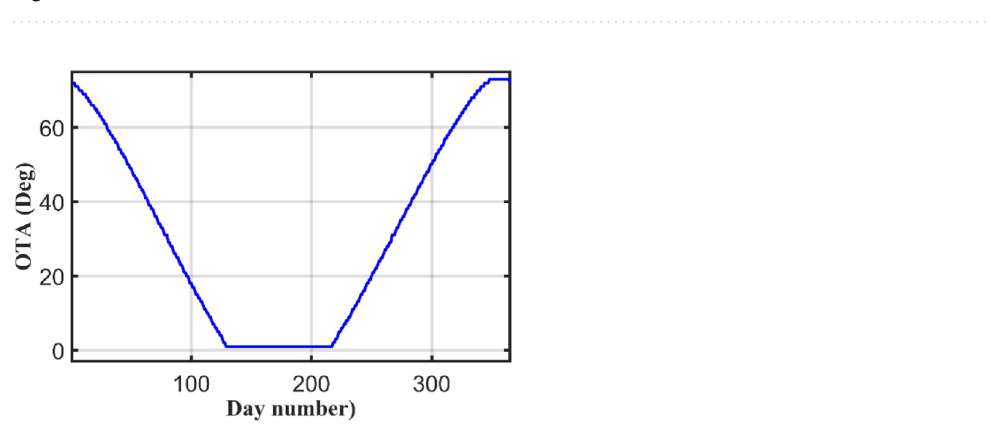
Figure 2. The influence of TA variation on extraterrestrial solar radiation.